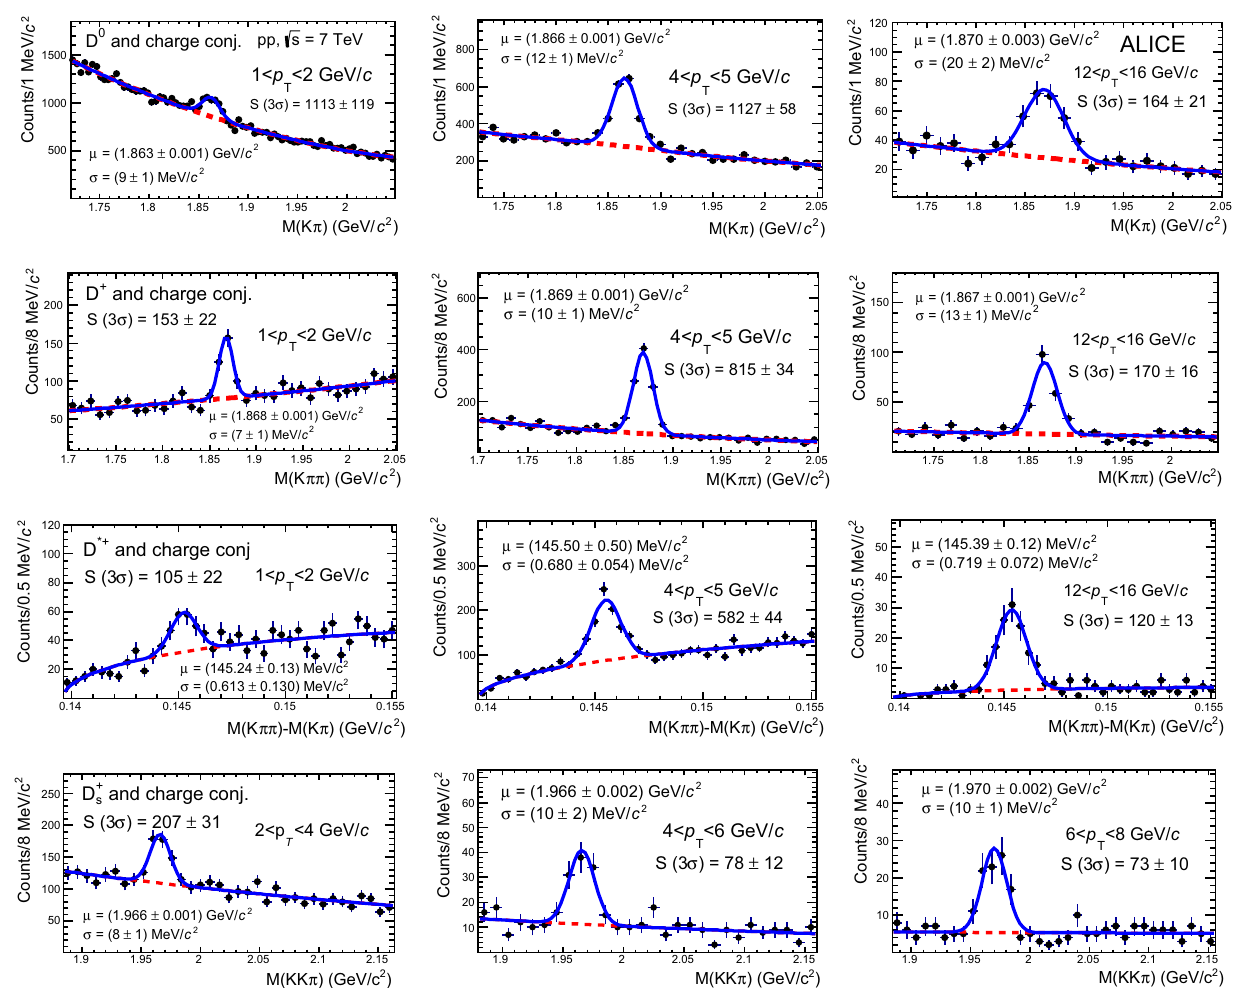
Fig. 1 Invariant-mass (mass-difference) distributions of D 0 , D + , of reflections for the D 0 meson is included. The values of mean ( μ ) and (D ∗+ ) and D + s candidates and charge conjugates in three p T intervals width ( σ ) of the signal peak are reported together with the signal counts √ s = 7 TeV with L int = 6 . 0 nb − 1 . The ( S ) in the mass interval ( μ − 3 σ,μ + 3 σ for a sample of pp collisions at curves show the fit functions as described in the text. The contribution